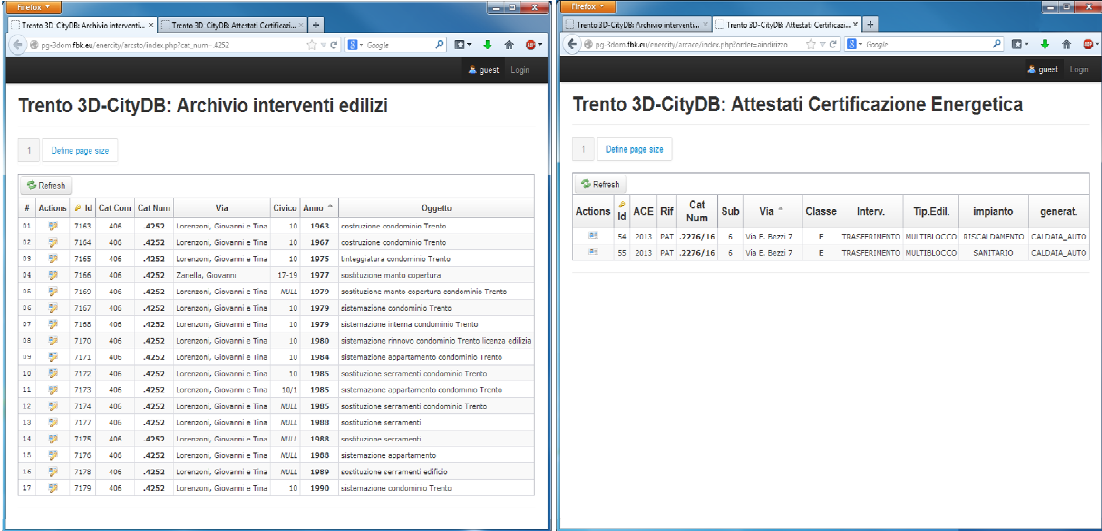
Figure 9 Example of information retrieval for a building: list of restoration, transformation and refurbishment activities carried over the time on the selected buildings (left); list of Energy Performance Certificates (EPCs) linked to the selected